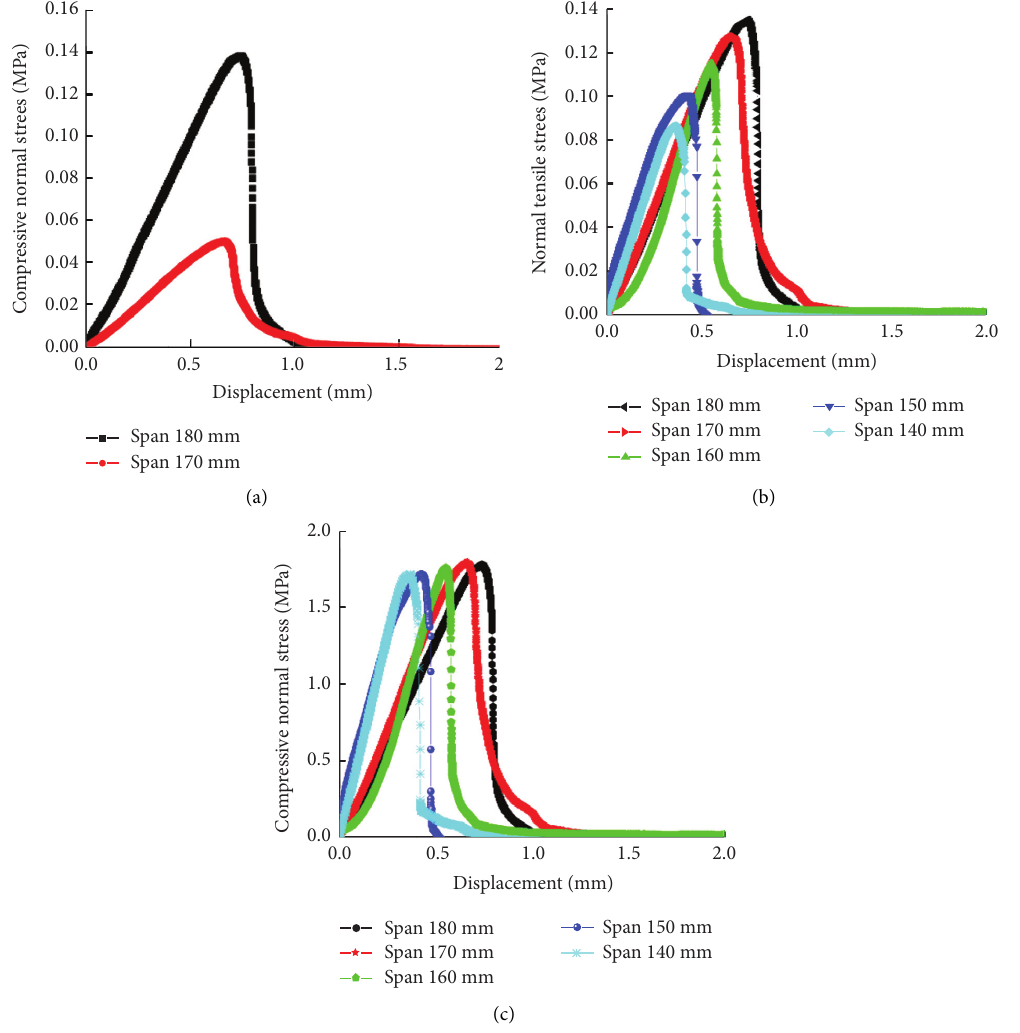
Figure 5: Stress-displacement curves of feature points with different spans. (a) Upper right feature point. (b) Middle right feature point. (c) Upper middle right feature point.